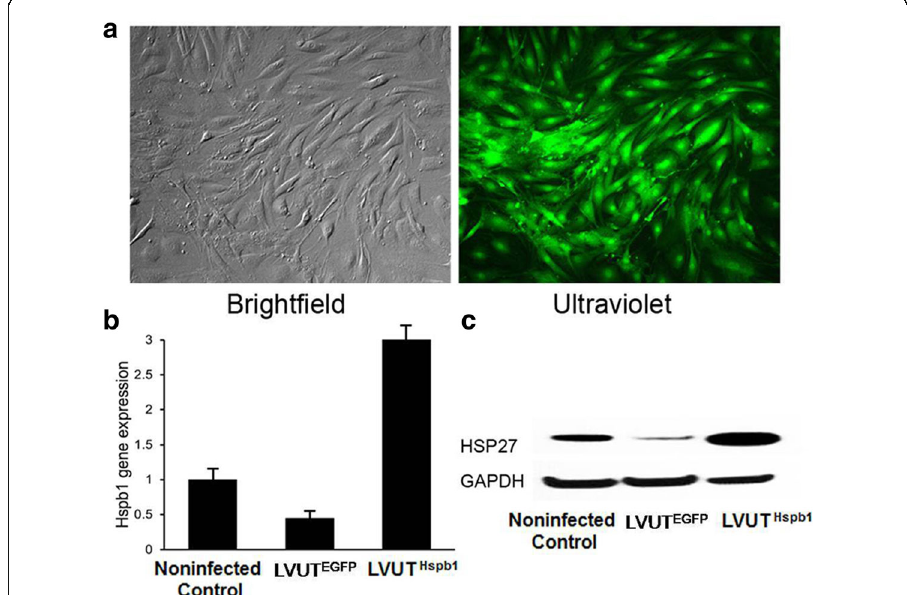
Fig. 4 Expressions of Hspb1 and HSP27 in A10 cells. a – Lentiviral infection is effective for overexpressing HSP27 in A10 cells, as shown by transfection with the vector containing the green fluorescent protein (GFP) gene, which makes the cells glow green under ultraviolet light. b – Quantitative PCR showing the Hspb1 expression level of non-infected A10 cells (non-infected control), A10 cells infected with Lenti6.3-EGFP empty vector (LVUT EGFP ), and A10 cells infected with LVUT Hspb1 (LVUT Hspb1 ). p < 0.05 between each pair of groups. Non-infected control, n = 4; LVUTE GFP , n = 4; LVUT Hspb1 , n = 4. c – A10 cells infected with LVUT Hspb1 express higher HSP27 protein levels than LVUT EGFP and non-infected A10 cells. Glyceraldehyde 3-phosphate dehydrogenase (GAPDH) was used as loading control protein